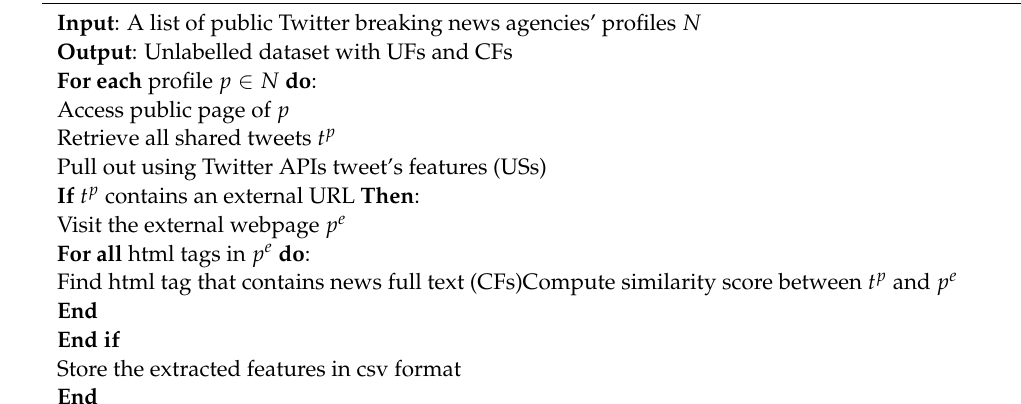
Algorithm 1 Pseudocode of dataset collection process for extracting UFs and